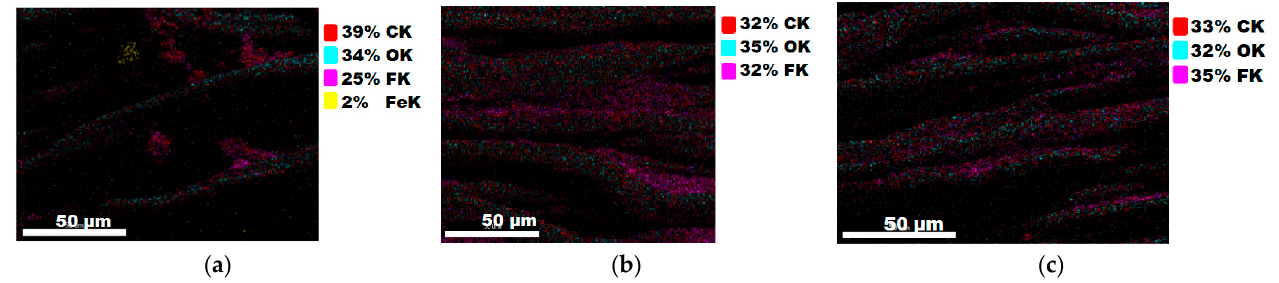
Figure 5. Smart elemental mapping overlay for sample 2: ( a ) untreated with artificial perspiration; ( b ) treated with acid perspiration; ( c ) treated with alkaline artificial perspiration.